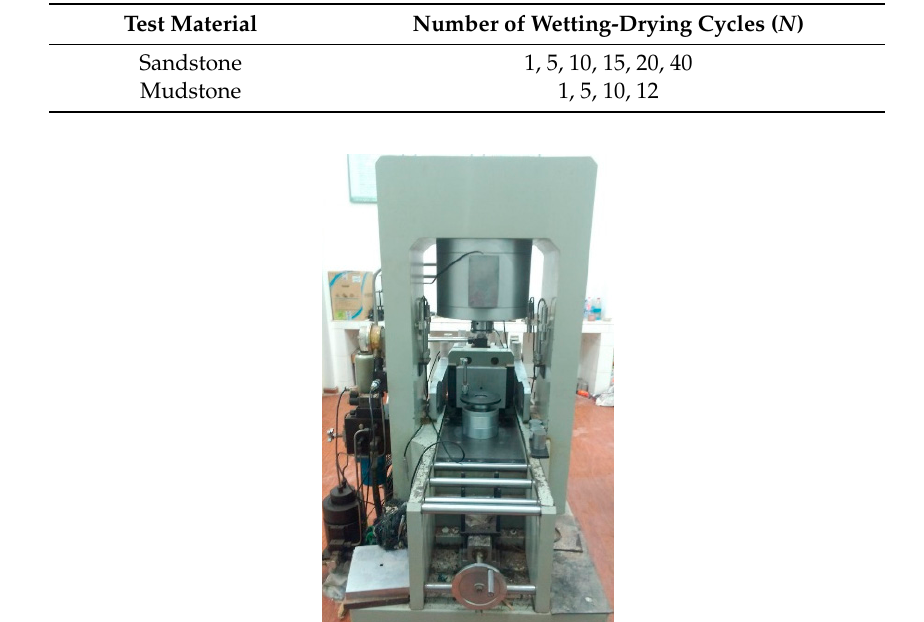
Figure 3. A protection device for mudstone specimen.